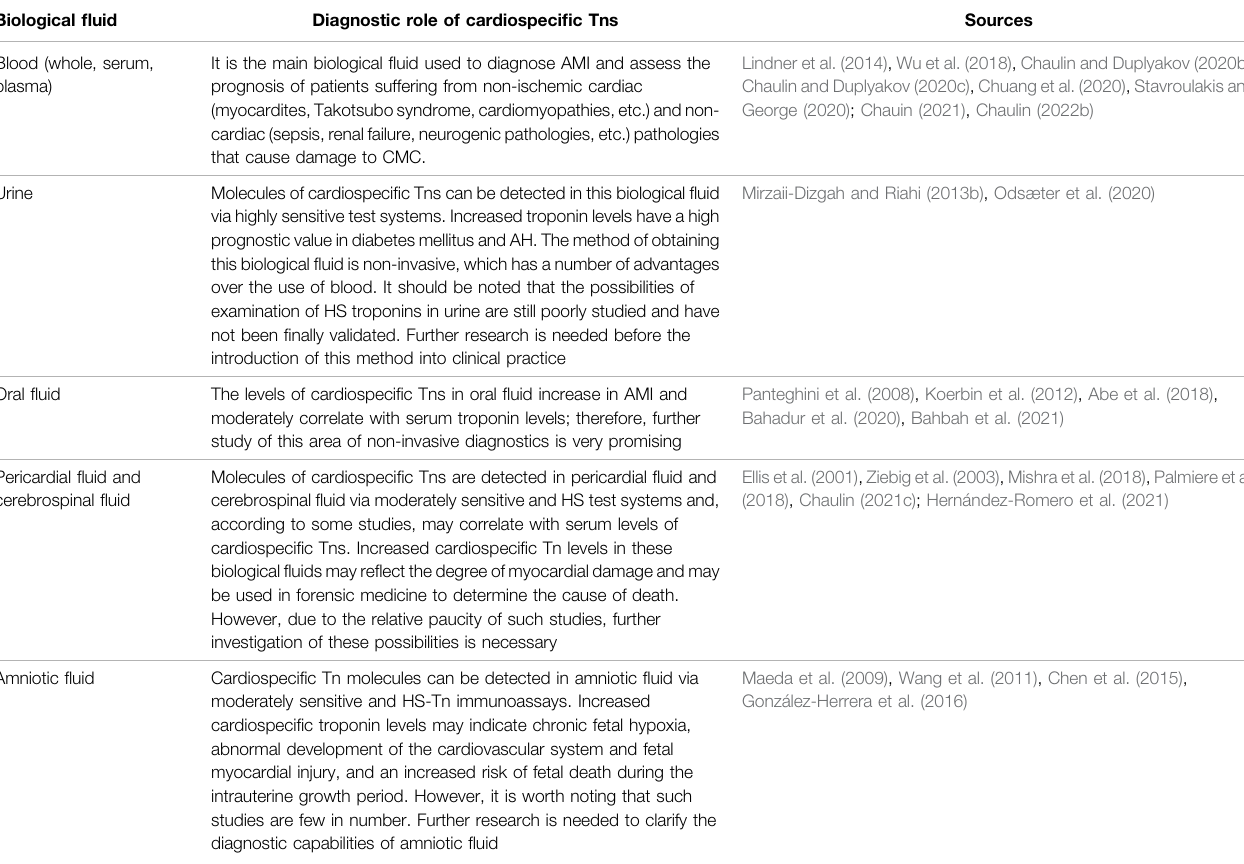
TABLE 2 | Biological fl uids in which the molecules of cardiospeci fi c Tns are detected and the diagnostic role. Biological fl uid Diagnostic role of cardiospeci fi c